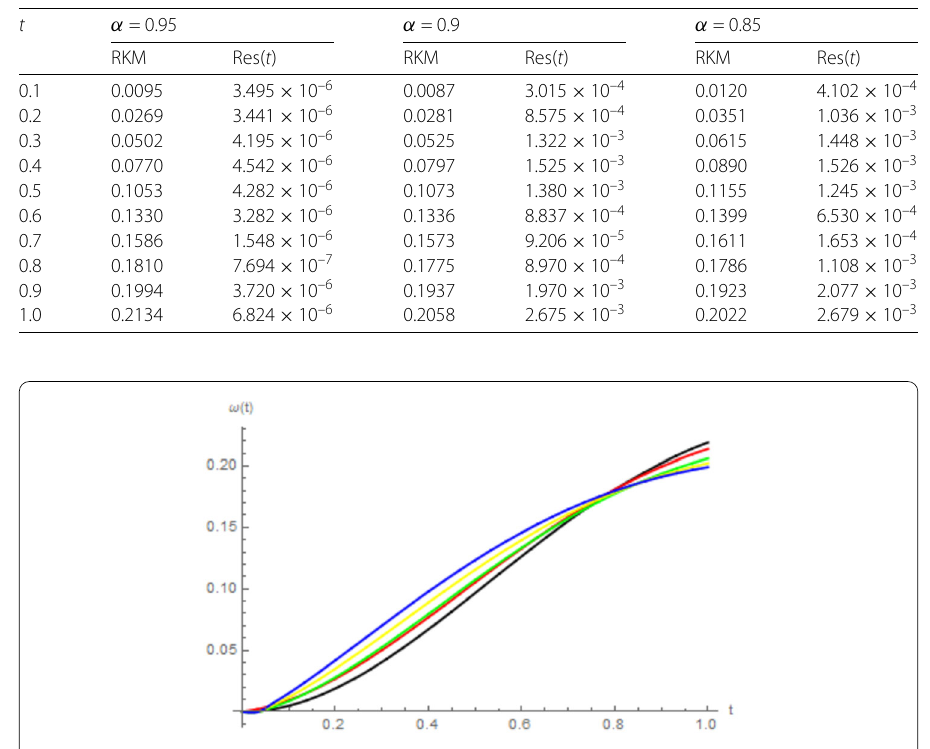
Figure 1 Fractional level curves of CF-derivative of Example 5.1: blue α = 0.8, yellow α = 0.85, green α = 0.9, red α = 0.95, and black α =